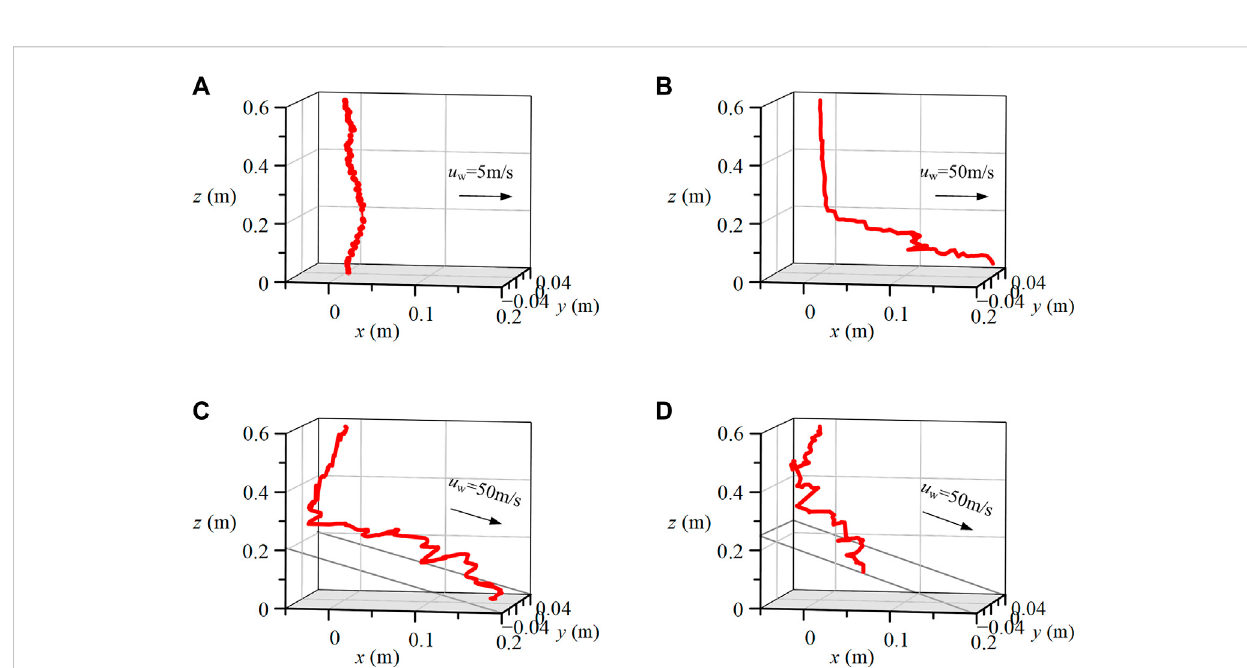
FIGURE 13 Arc deformation on the arc-connected surface with (A) u_w=5m/s, phi=0 ° , (B) u_w=50m/s, phi=07 ° , (C) u_w=50m/s, phi=15 ° , (D) u_w=50m/s, phi=30 °